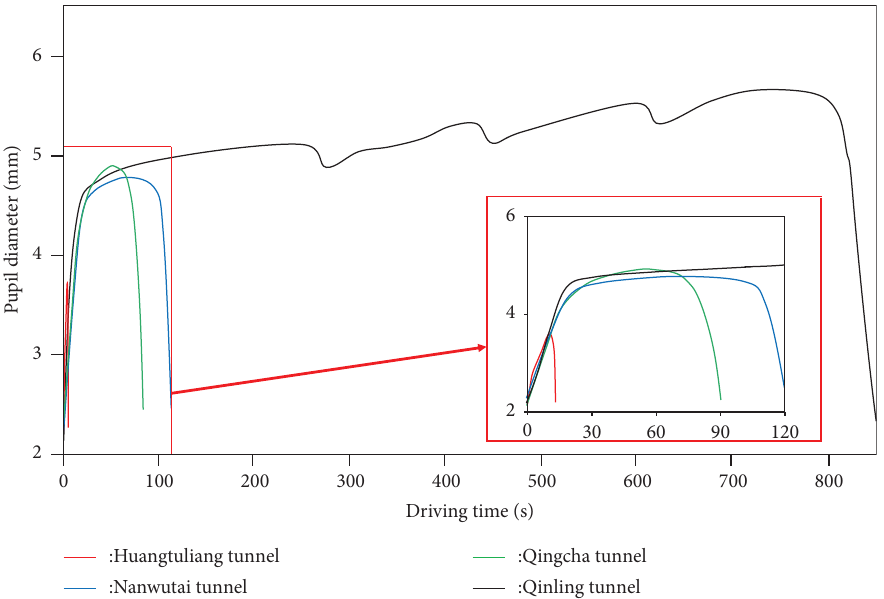
Figure 5: Pupil diameter changes of drivers in each tunnel.